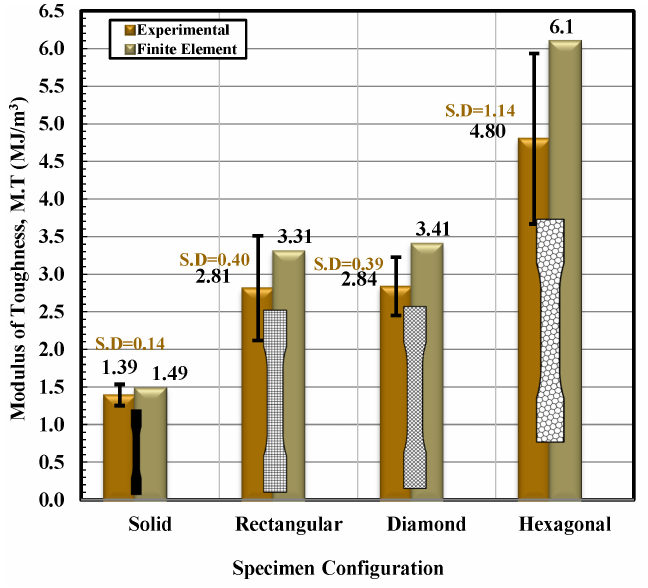
Figure 19. Strength at failure versus specimen configuration for both experimental and finite element analysis.